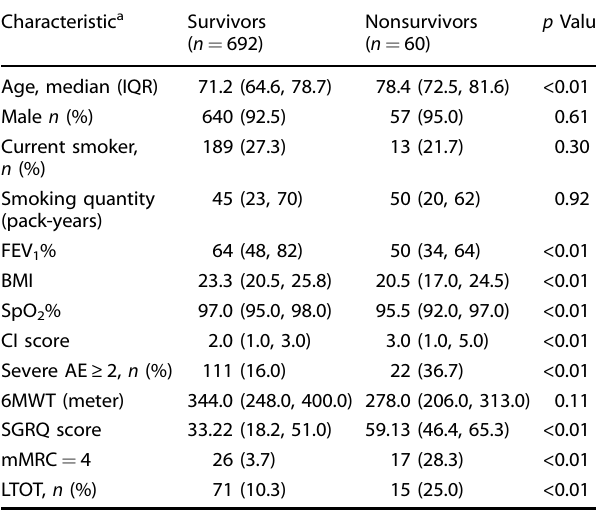
Table 1. Demographic and patient characteristics of survivors and nonsurvivors.